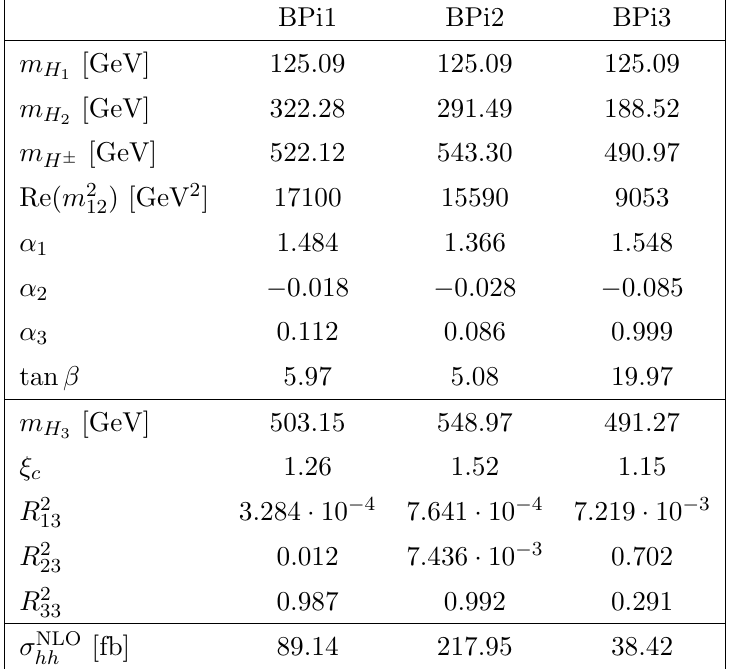
. Line 14: the NLO i 3